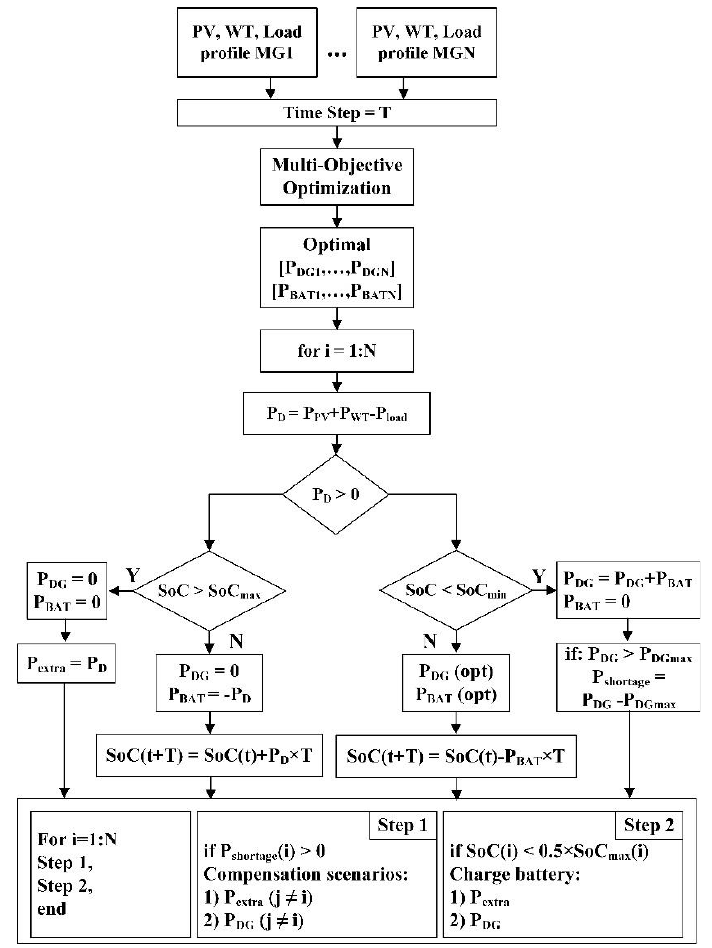
Figure 6. Hybrid control strategy in the NHMG.